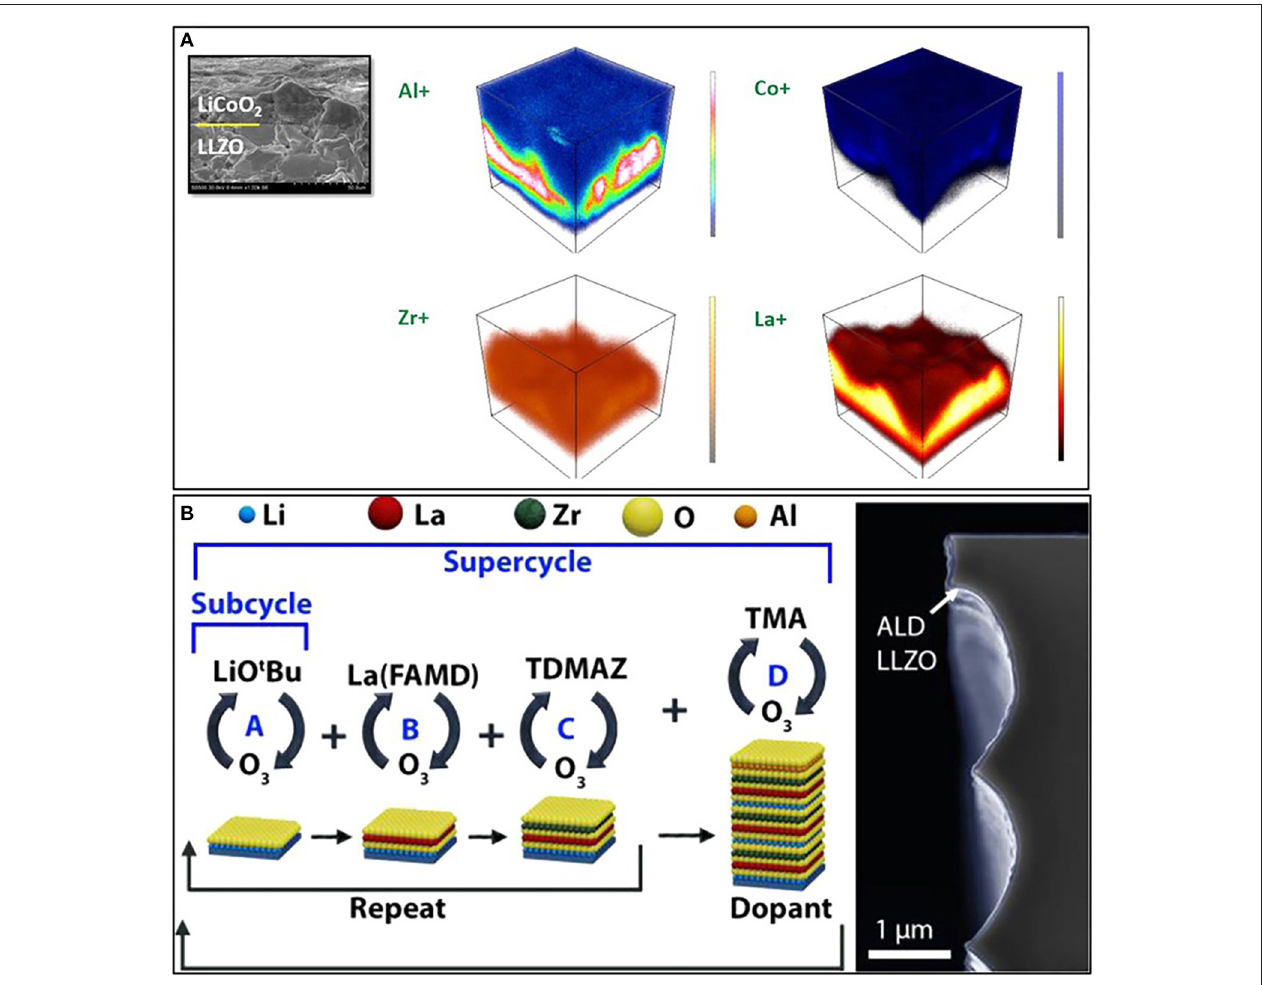
FIGURE 4 | (A) TOF-SIMS-enabled three-dimensional elemental maps of the LiCoO 2 / Li 7 La 3 Zr 2 O 12 (LLZO) interface that is displayed in the inset SEM image. [Reprinted with permission from ( Park et al., 2016). Copyright (2016) American Chemical Society]. (B) Schematic representation of an ALD super cycle composed of constituent binary ALD processes (left) and SEM image showing as-deposited ALD LLZO film (right). [Reprinted with permission from (Kazyak et al., 2017). Copyright (2017) American Chemical